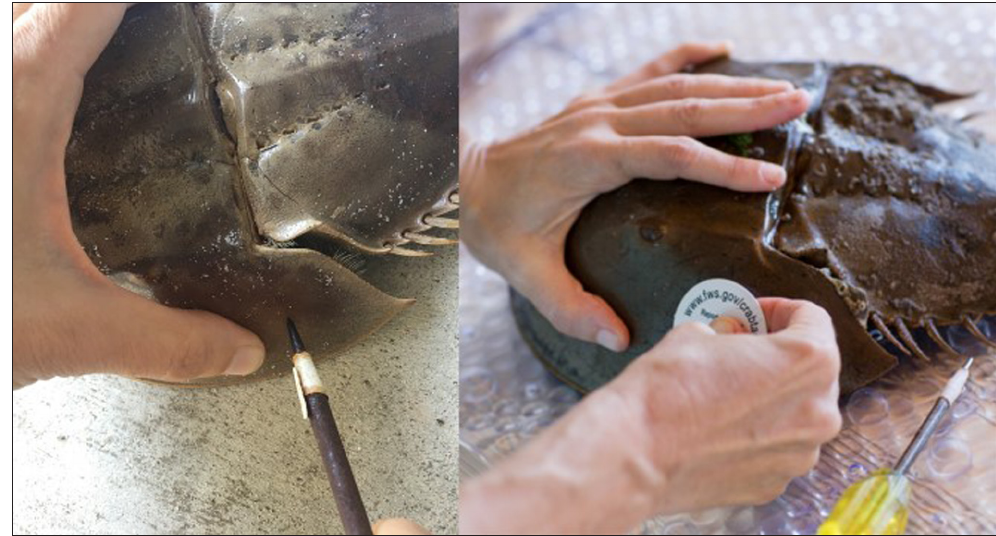
Figure 1 American horseshoe crab being tagged using an awl to create a small hole in the prosoma, and insertion of a U.S. Fish and Wildlife Service